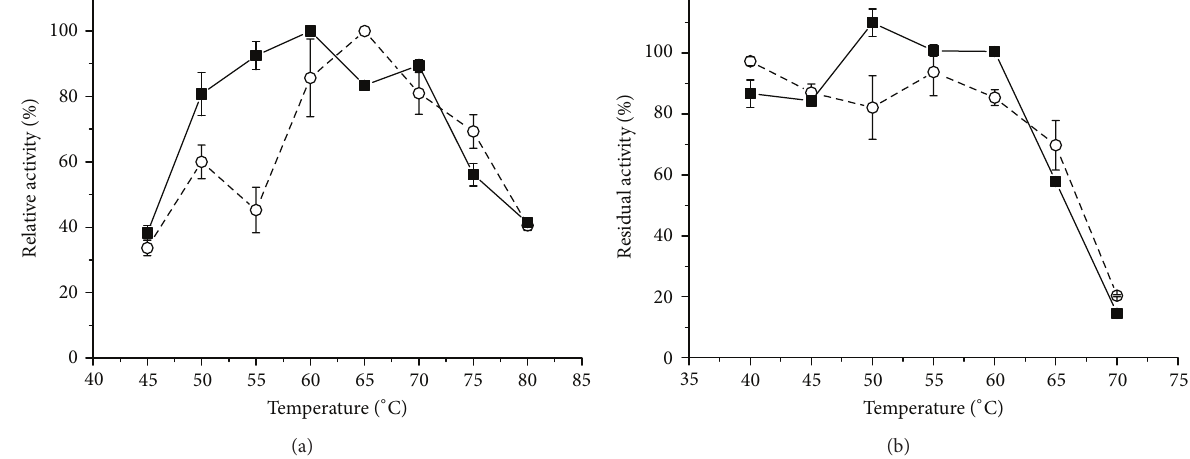
Figure 5: Effect of temperature on the activity of endoglucanase of the crude extract from M . heterothallica F.2.1.4. at pH 5.5. (a) ( ◼ ) SSCWB and ( I ) SmCP, respectively. Temperature effect on the stability of the endoglucanases. (b) ( ◼ ) SSCWB and ( I ) SmCP, respectively.